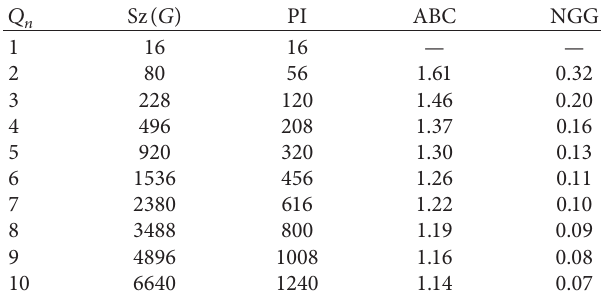
Table 28: Comparison table for para chain.